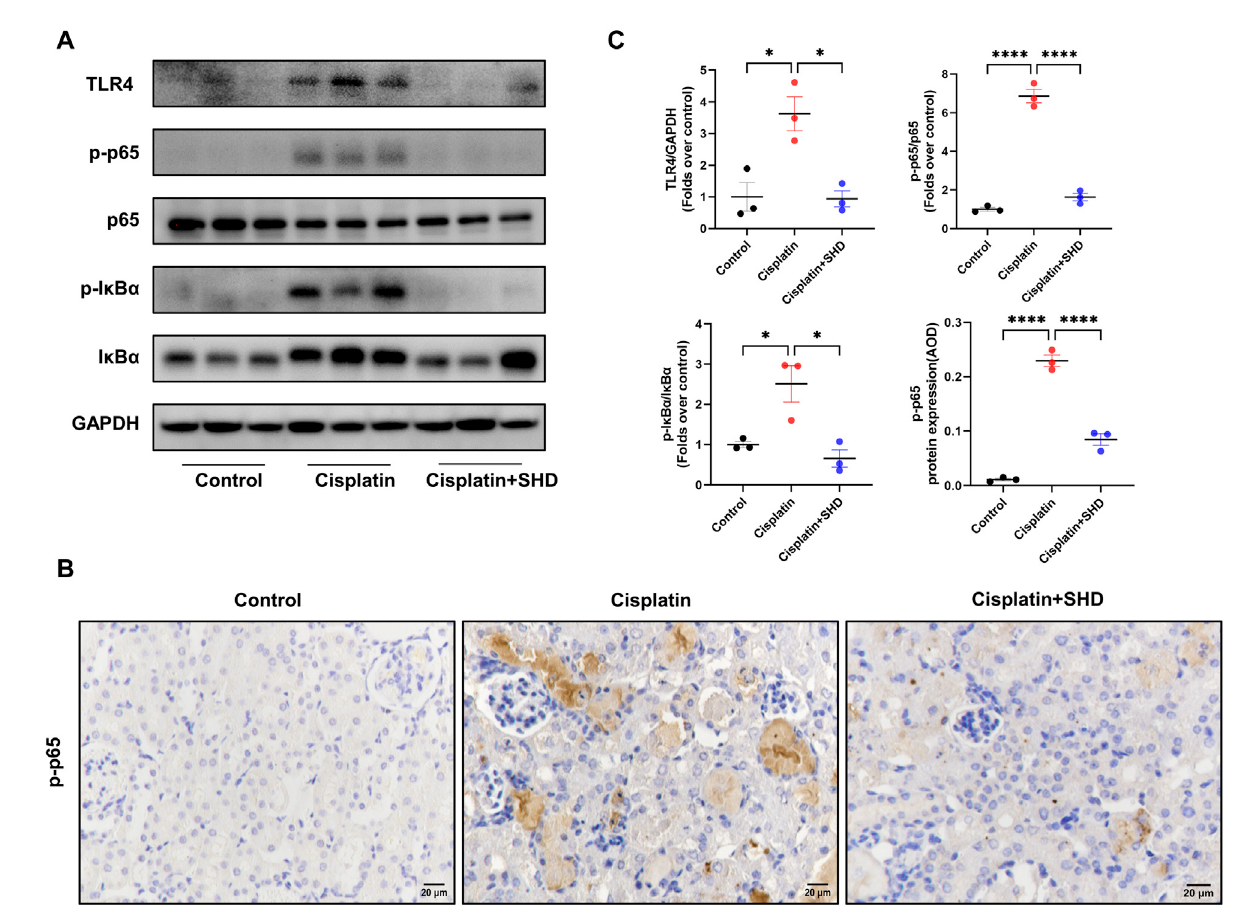
FIGURE 9 EffectsofSHDonNF- κ Bactivityinthekidney. (A) RepresentativeWesternblotimagesofTLR4,phospho-NF- κ Bp65,NF- κ Bp65,phospho-IkBa,andIkBa in the kidneys. (B) Representative IHC images of phospho-NF- κ B p65 protein in renal cortical glomeruli and tubular epithelium. Scale bar = 20 μ m. (C) Densitometric analyses of phospho-NF- κ B p65/NF- κ B p65, phospho-IkBa/IkBa, and TLR4 proteins expression normalized to GAPDH content ( n = 3). Semiquantitative analysis of IHC for the phospho-NF- κ B p65 protein expression. Data presented are means ± SEM. p p < 0.5, pppp p < 0.0001. Original magni fi cation